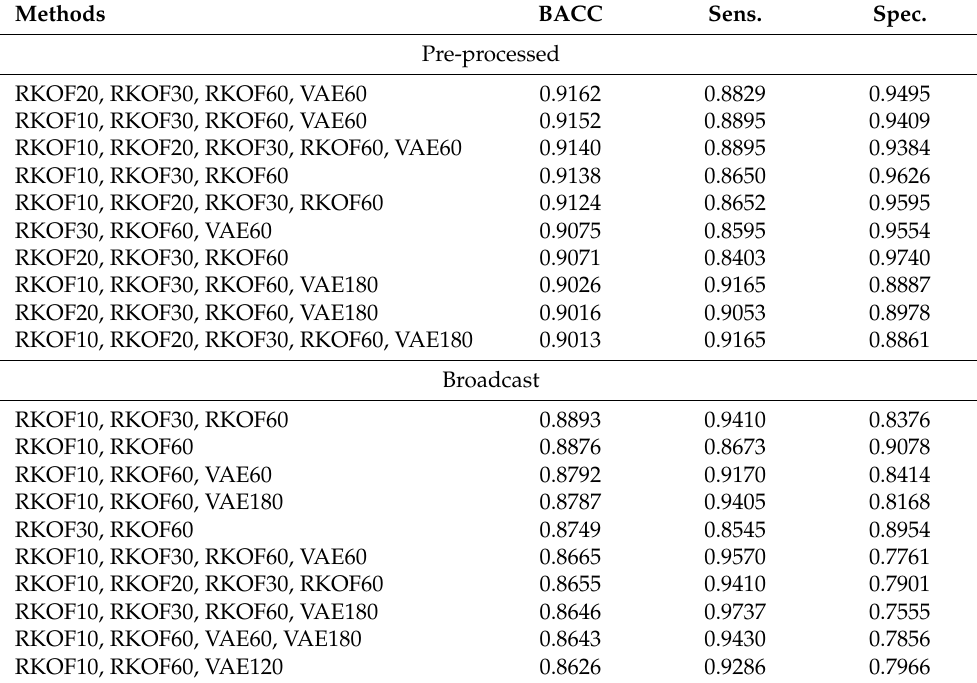
Table 4. Top 10 method combinations arranged by balanced accuracy.